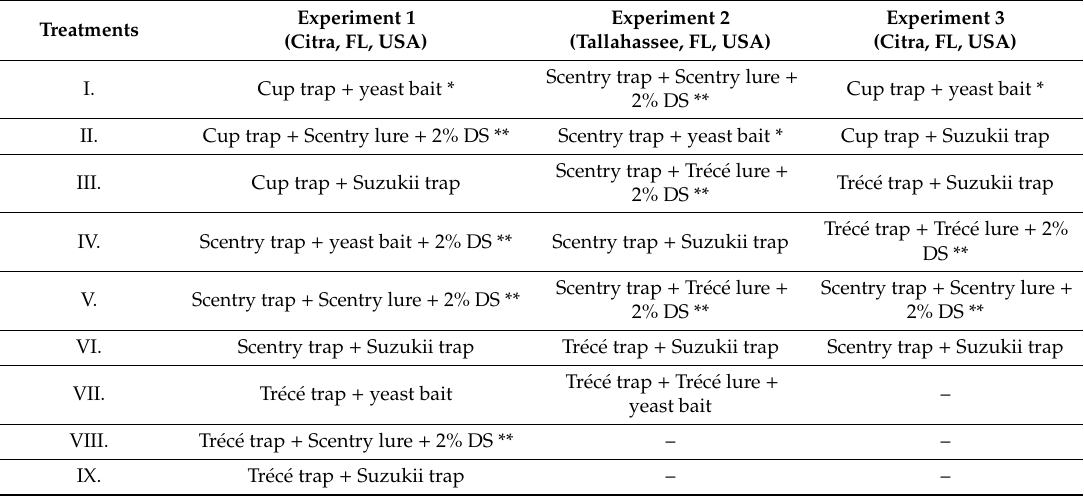
Table 1. List of various treatments for three experiments conducted in Citra and Tallahassee (blueberry planting) and Citra (blackberry planting).